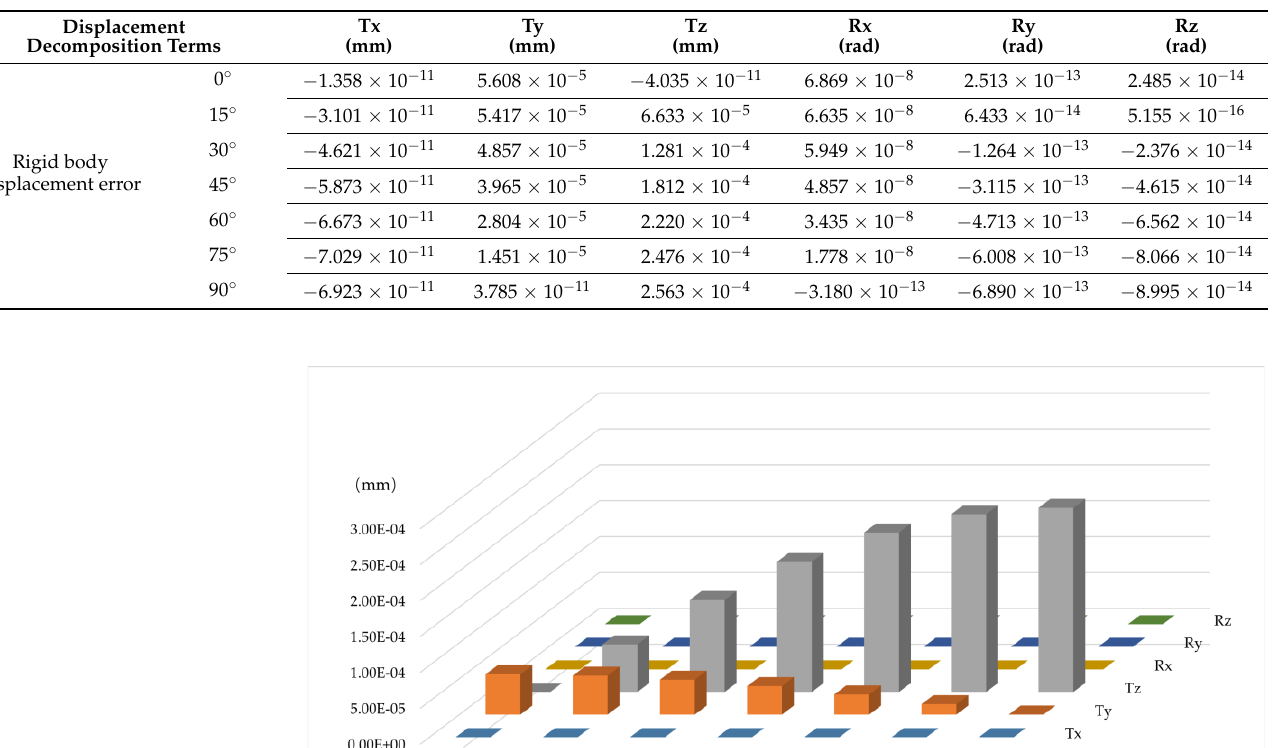
Figure 10. Normalized surface after removing rigid body displacement of L1S1.